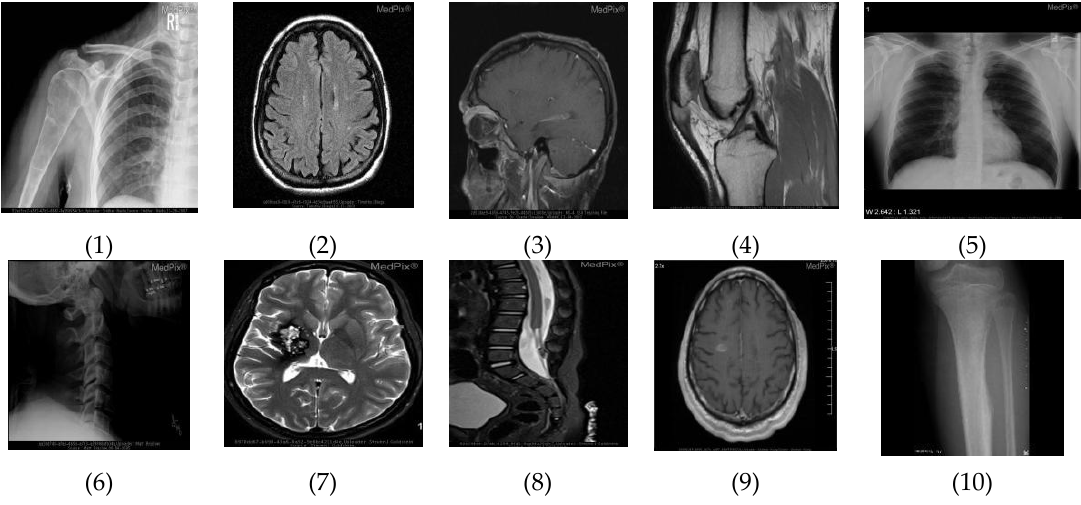
Figure 2. Set of testing images (referred to as 1 to 10, from left-to-right and top-to-bottom).